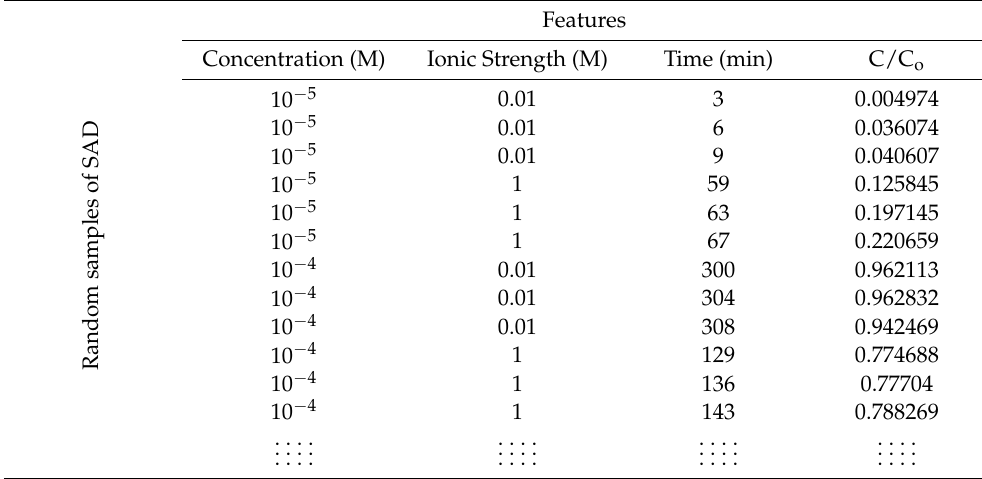
Figure 3. Schematic diagram of the fixed-bed adsorption column. Table 1. Descriptive statistics analysis of the